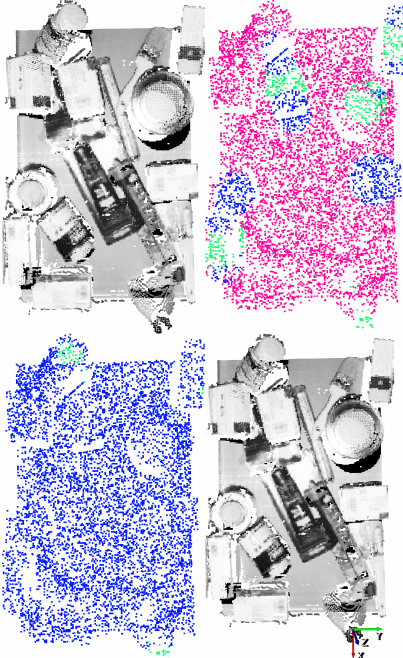
Figure 14. Gripper result example for n = 4. Top-left: point cloud of the scene. Top-right: ground- truth annotation. Bottom-left: Top-1% predictions. Bottom-right: Top-1 grasping point. The vertical orientation for the gripper is determined by the y (green) axis.